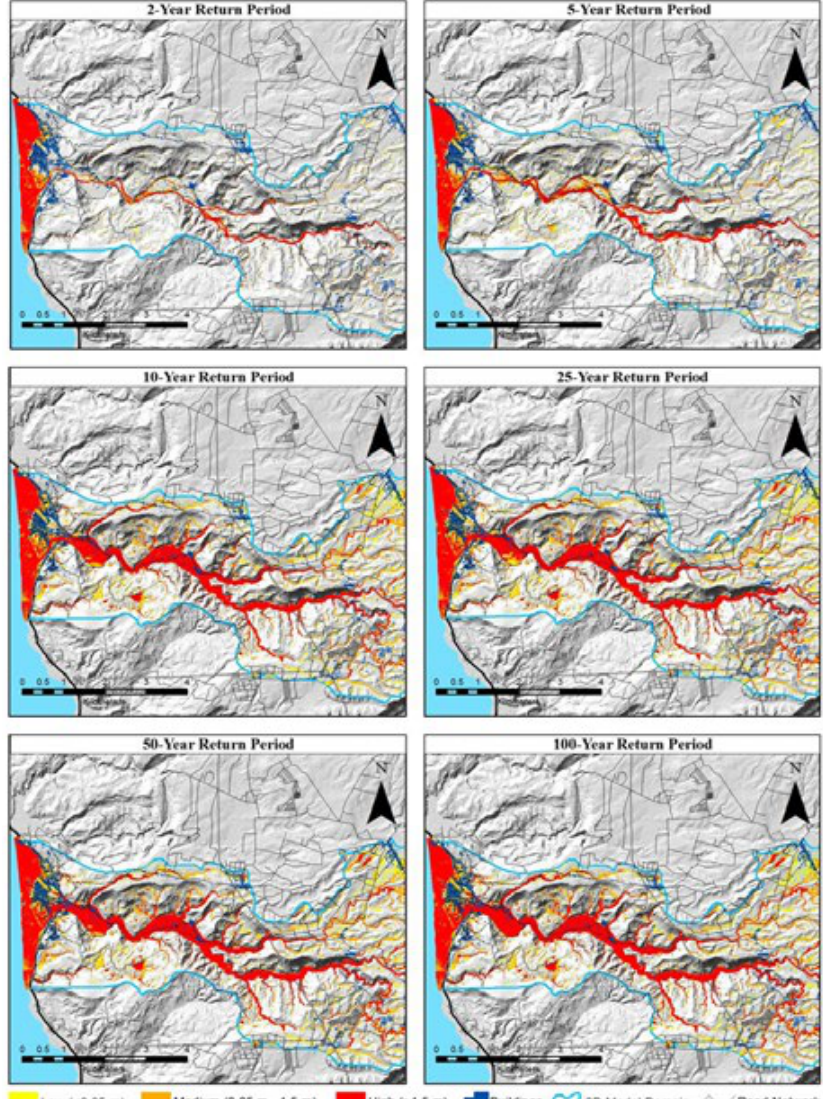
Fig. 7: Flood hazard maps in Solana watershed for the six return period scenarios.